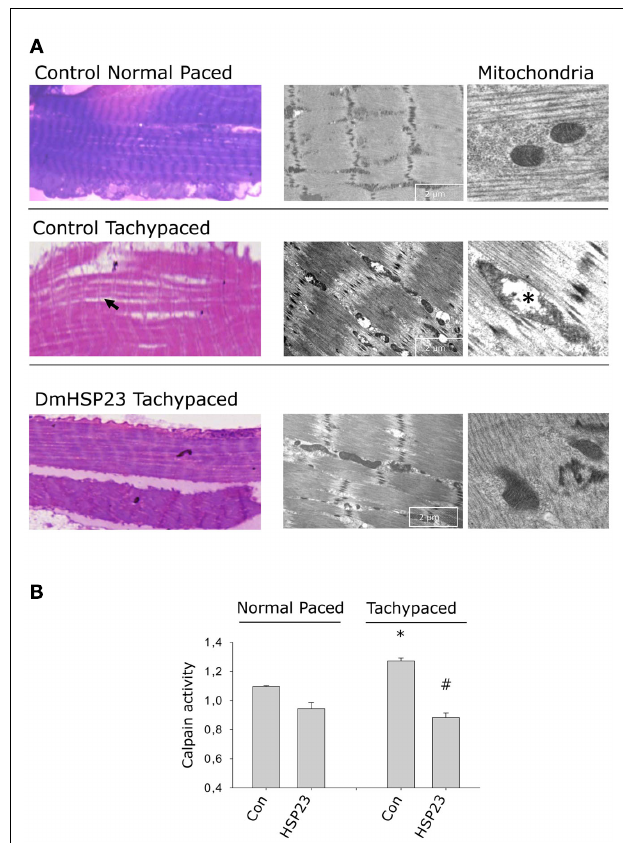
FIGURE 3 | HSP23 overexpressing Drosophila are protected against tachypacing-induced structural remodeling, including loss of sarcomeres (myolysis) and mitochondrial damage. (A) Left panel shows light microscopic structure of the heart wall in normal paced and tachypaced control and DmHSP23 overexpressing strains. Right panel shows electron microscopic details of the cardiomyocytes and mitochondria. Arrowhead shows loss of sarcomeres in the heart wall and asterisk marks mitochondrial damage. (B) Tachypacing induces calpain activity, and DmHSP23 (UAS-actin GAL4-DmHSP23) overexpressing strains were protected. * P < 0.05 vs. control normal paced, # P < 0.05 vs. control tachypaced. Figure adapted from Zhang et al.